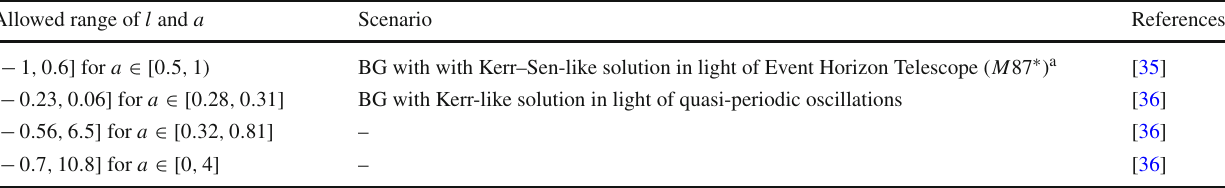
Table 1 The allowed ranges of l , that have been obtained via con- fronting the BG black hole with observational data. The constraint reported in the third to fifth rows, respectively come from the